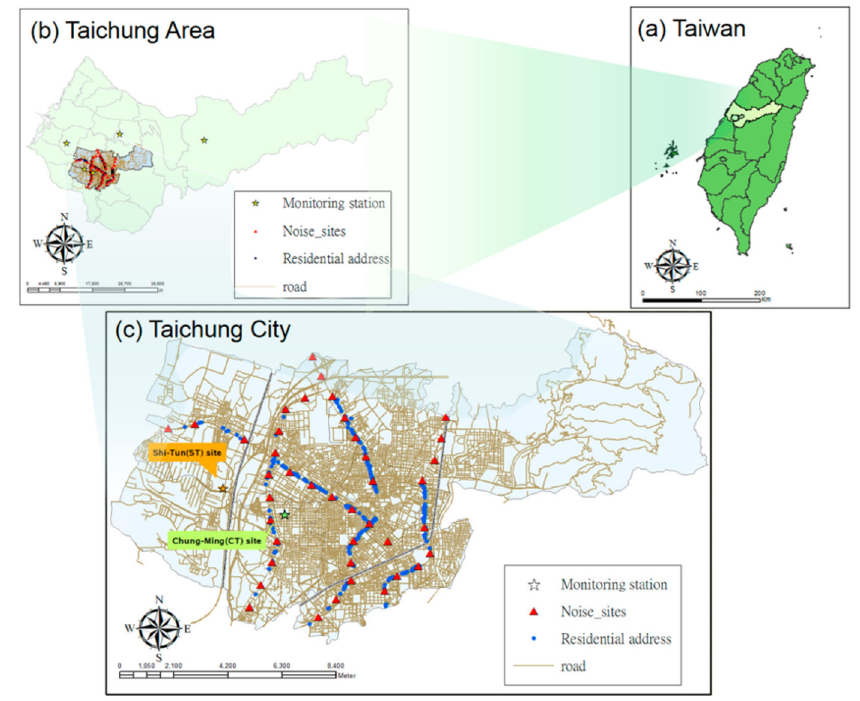
Figure 1. Locations of noise, air quality monitoring stations, and subjects’ house addresses. ( a ) Taiwan; ( b ) Taichung area; ( c ) Taichung